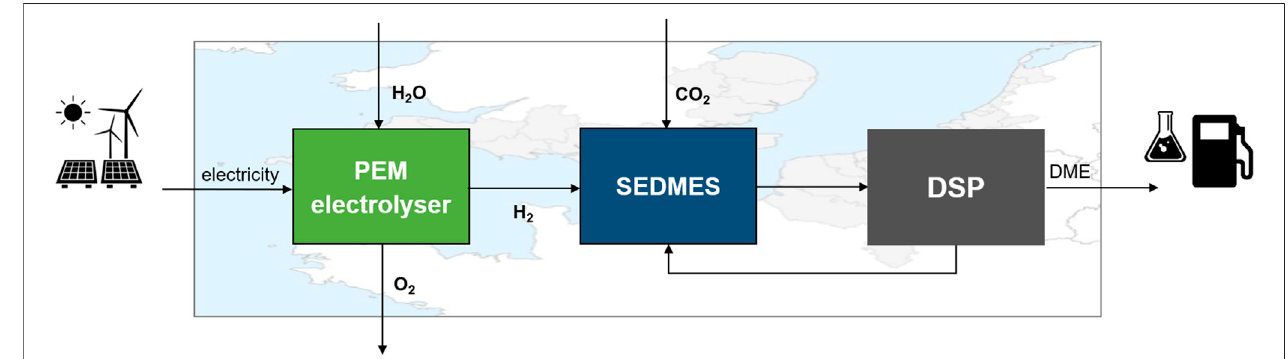
FIGURE 2 | Overview of the envisioned PtX process to convert CO 2 to dimethyl ether and scope of the techno-economic assessment.